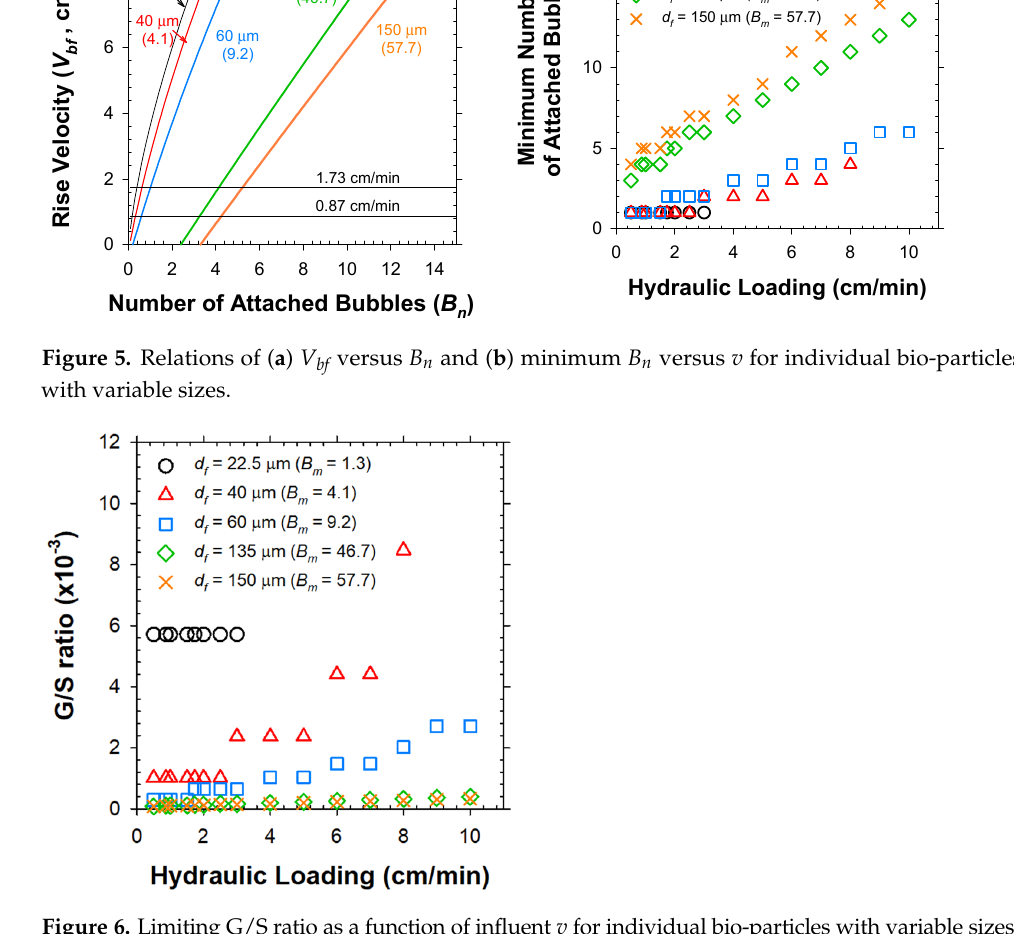
Figure 6. Limiting G/S ratio as a function of influent v for individual bio-particles with variable sizes.